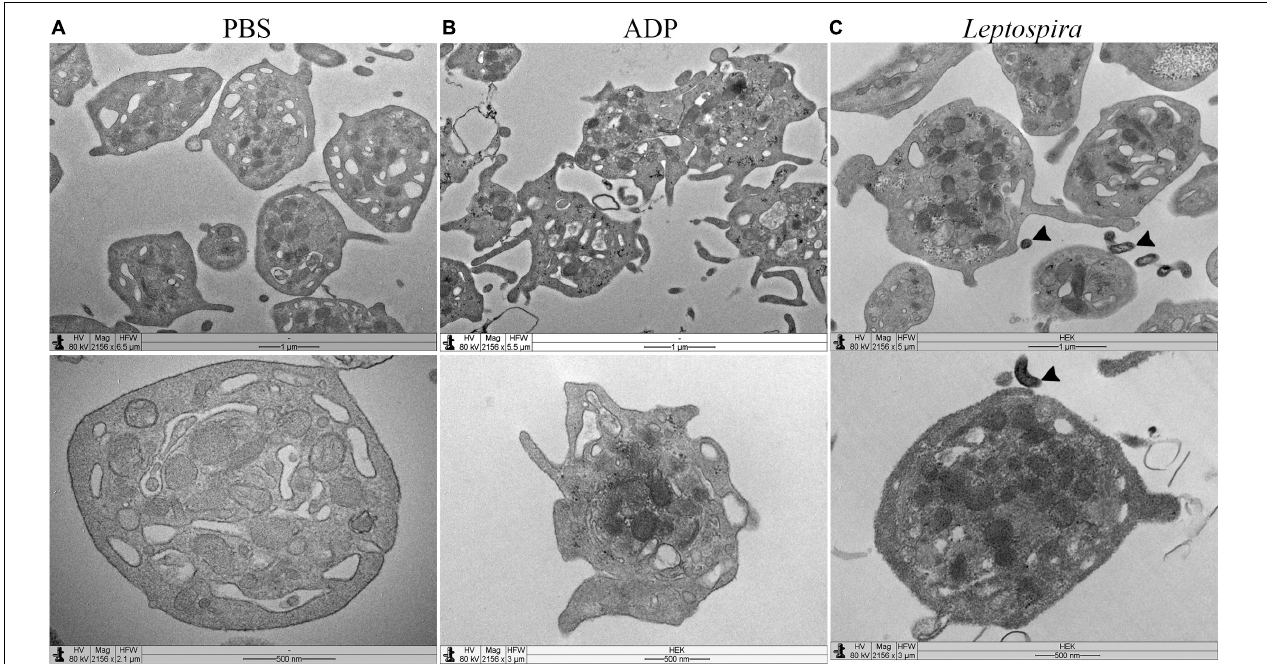
FIGURE 6 | TEM of platelets incubated in suspension with different stimuli. Washed platelets were incubated in suspension with buffer alone ( A , negative control for platelet activation), ADP ( B , positive control for platelet activation), or live virulent L. interrogans serovar Copenhageni cells (C) for 30 min. After fixation, the samples were prepared for TEM and visualized with a LEO 906 E (Zeiss) transmission electron microscope.